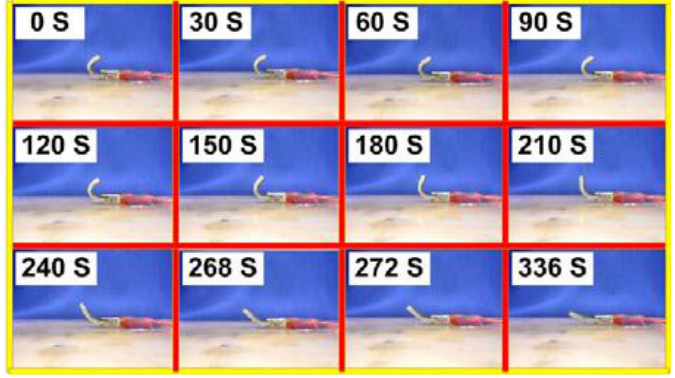
Figure 4. Snapshot of the shape recovery process in an SMP nanocomposite integrated with 1.2 g of CNT nanopaper. Reproduced with permission from [49]. Copyright